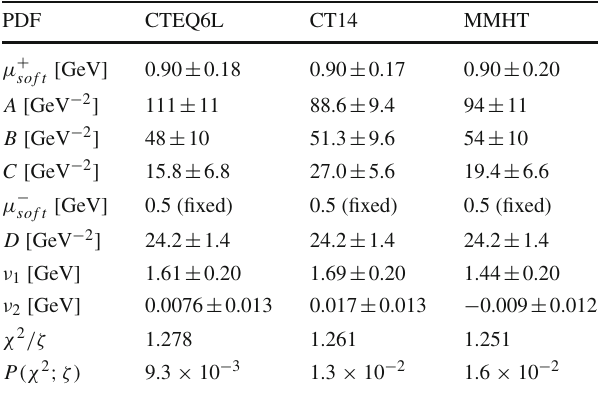
Table 7 Best-fit parameters of our model without ATLAS data and √ s min = 10 GeV. The number of degrees of freedom low-energy cutoff is ζ =